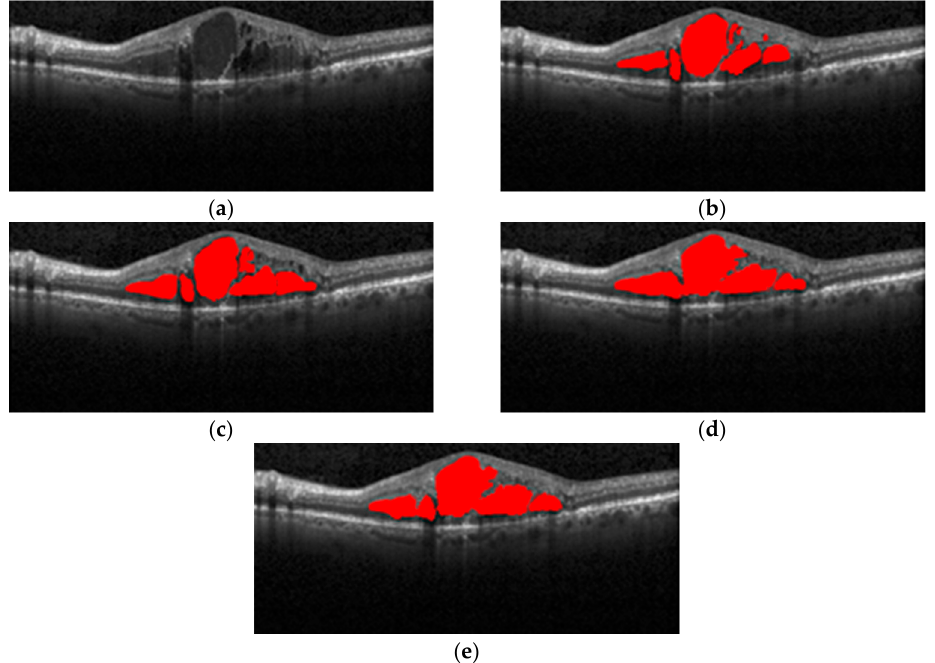
Figure 13. Segmentation effect diagram: ( a ) original image; ( b ) expert 1 annotations; ( c ) expert 2 annotations; ( d ) the method of introducing ResNet101 predictions; ( e ) the proposed method predictions.